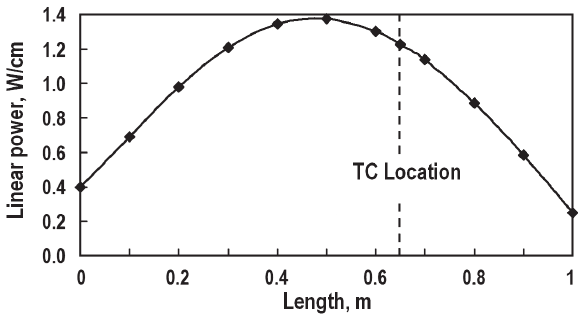
Figure 2. Axial active part linear power